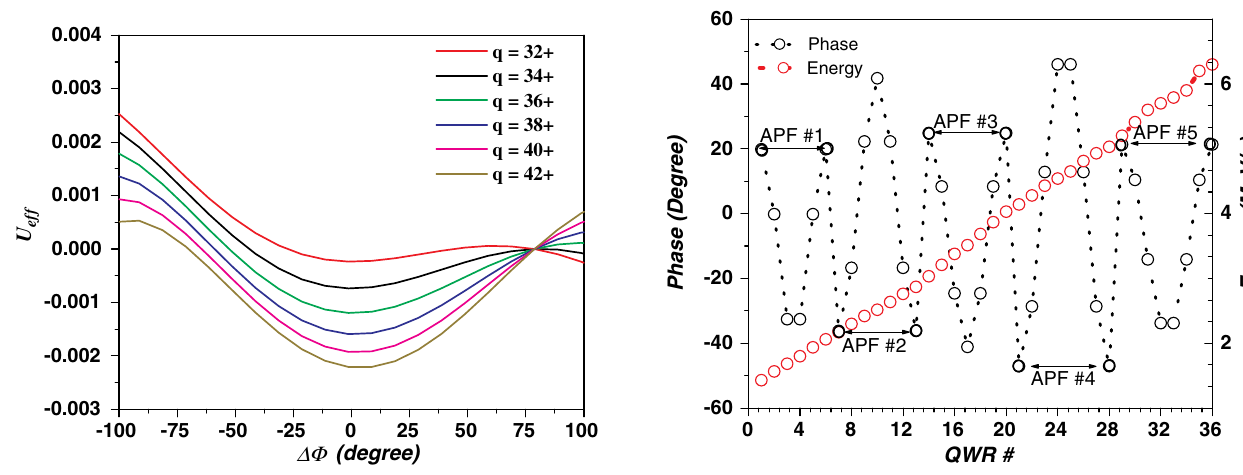
FIG. 2. Potential bucket calculated for different charge states for APF period 1 tuned for q ¼ 34 þ .